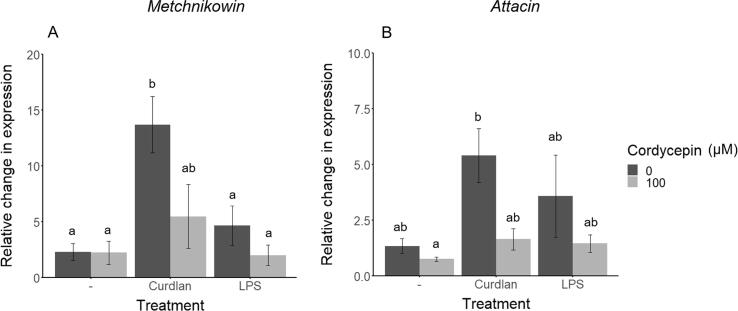
Expression of AMPs in D. melanogaster S2r+ cells in response to cordycepin treatment. S2r+ cells (three biological replicates) were treated with DMSO (dark grey bars) or DMSO plus 25 µg ml−1 (100 µM) cordycepin (light grey bars). Immune challenge was simulated using 20 µg ml−1 LPS or curdlan. Cells were sampled 4 h after treatment. Fold changes in gene expression were calculated using the 2-ΔΔCT method (Schmittgen and Livak, 2008) compared to untreated samples with correction for the internal control (RP49). Relative expression of A) metchnikowin and B) attacin A is shown. Error bars show ± SEM and different lowercase letters indicate significant differences (p < 0.05; ANOVA, Tukey HSD post hoc tests).